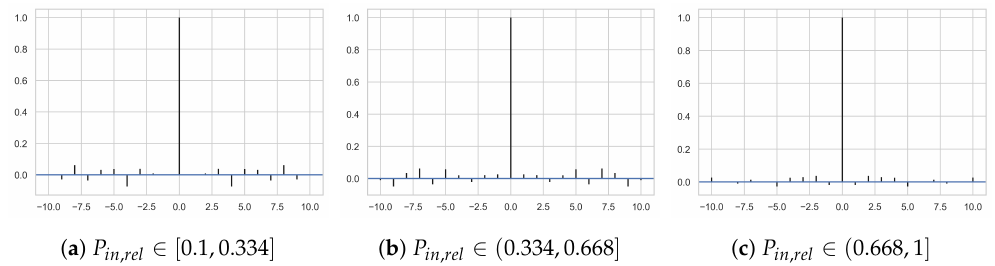
Figure A3. Autocorrelation plots for all three residuals ˆu ( i ) obtained from the linear submodels for data sets i ∈ { 1,2,3 } . The appearance of any bars but one at x = 0 being visibly larger than 0.1 suggests autocorrelation of the respective